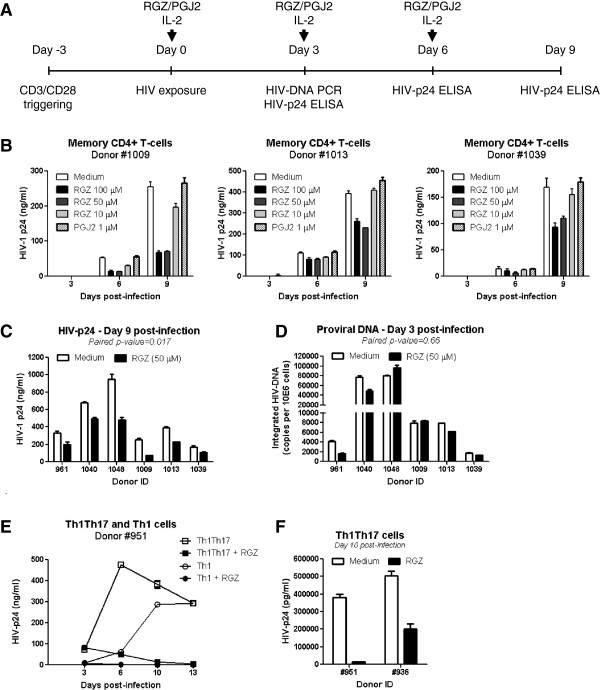
Activation of PPARγ pathway negatively regulates HIV replication in T-cells. Memory CD4+ T cells were stimulated via CD3/CD28 for 3 days. (A) Cells were then exposed to replication competent NL4.3BAL-GFP HIV (50 ng HIV-p24/106 cells) for 3 h at 37°C. Unbound virus was removed by extensive washing. HIV-infected cells were cultured in the presence of IL-2 (5 ng/ml) and Rosiglitazone (RGZ; 10, 50, and 100 μM) or prostaglandin J2 (PGJ2; 1 μM). Media was refreshed every 3 days. Supernatants were harvested at day 3, 6 and 10 post-infection for HIV-p24 quantification by ELISA, while a fraction of cells harvested at day 3 post-infection was used for integrated HIV-DNA quantification by real-time PCR. (B) Shown are kinetics of HIV-p24 expression in culture supernatants (n = 3; mean±SD of triplicate wells). (C) Shown are statistics of HIV-p24 levels in supernatants collected at day 9 post-infection from memory CD4+ T-cells cultured in the presence or the absence of RGZ (50 μM) (n = 6). (D) Shown are integrated HIV-DNA levels at day 3 post-infection in memory CD4+ T-cells cultured in the presence or the absence of RGZ (50 μM) upon infection (n = 6). (E) Matched Th1Th17 and Th1 cells were sorted by flow cytometry, stimulated and exposed to NL4.3BAL-GFP HIV as above, and cultured with IL-2 (5 ng/ml) in the presence or absence of RGZ (50 μM). Levels of HIV-p24 were quantified by ELISA at days 3, 6, 10, and 13 post-infection. Shown are results from one donor representative of results obtained with cells from two different donors. (F) Shown are the effects of RGZ (50 μM) on HIV replication in Th1Th17 cells from two different donors at day 10 post-infection. (C-D) Paired t-Test values are indicated on the graphs (n = 6).